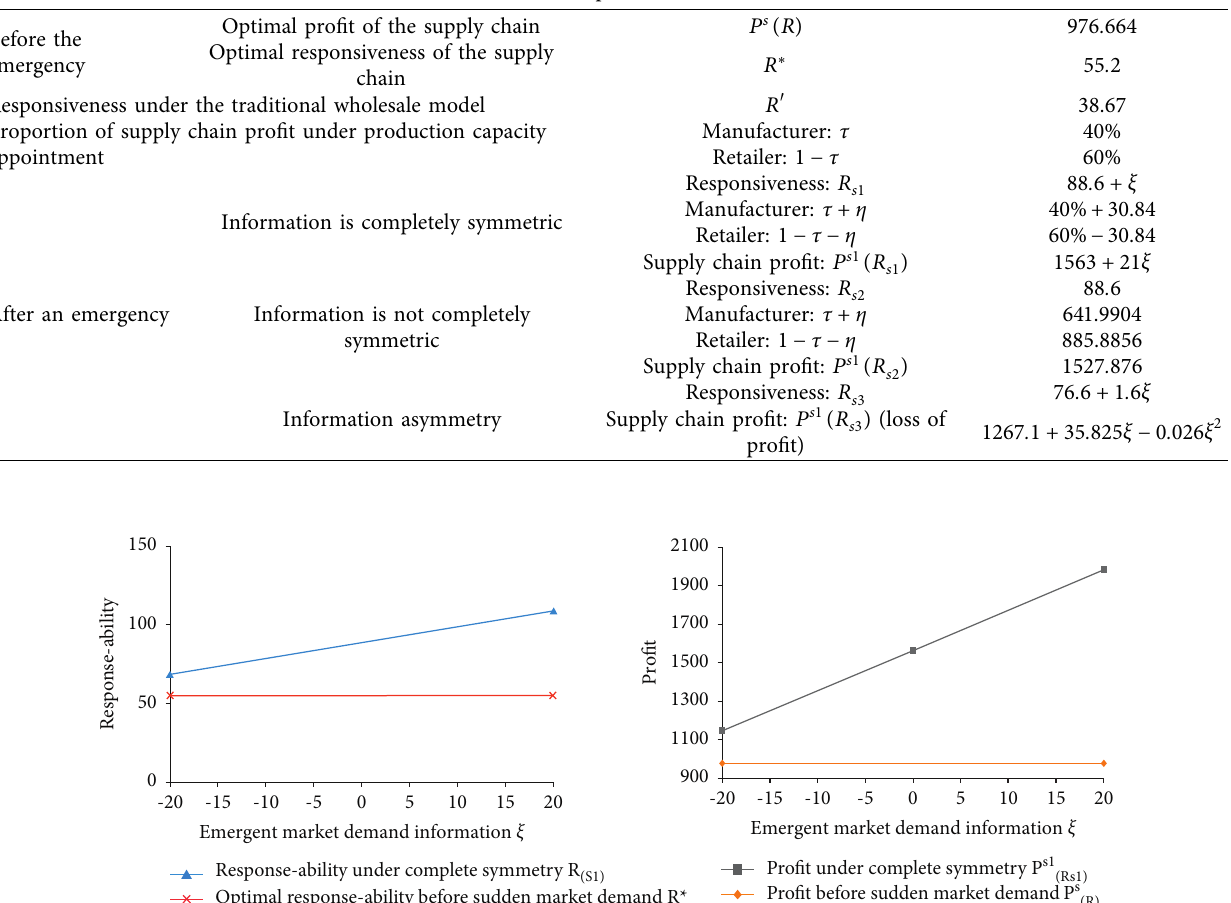
Table 2: Values of various parameters in different states.